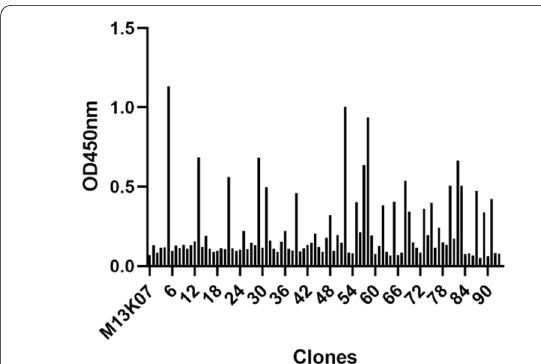
Fig. 5 Detection of the immune activity of recombinant phages against adenovirus using phage ELISA. Recombinant phages prepared from 92 randomly selected clones were added to the microplates coated with adenovirus vector rAd26. The M13K07 helper phage was used as a negative control, and PBS was used as a blank control. The HRP/anti-M13 monoclonal antibody was used to detect the bound phage. The highest OD450 nm value of the recombinant phage was 1.133, and the lowest value was 0.052. The negative control was 0.07. Two positive clones with the highest OD450 nm value were selected and named sdAb 5 and sdAb 31